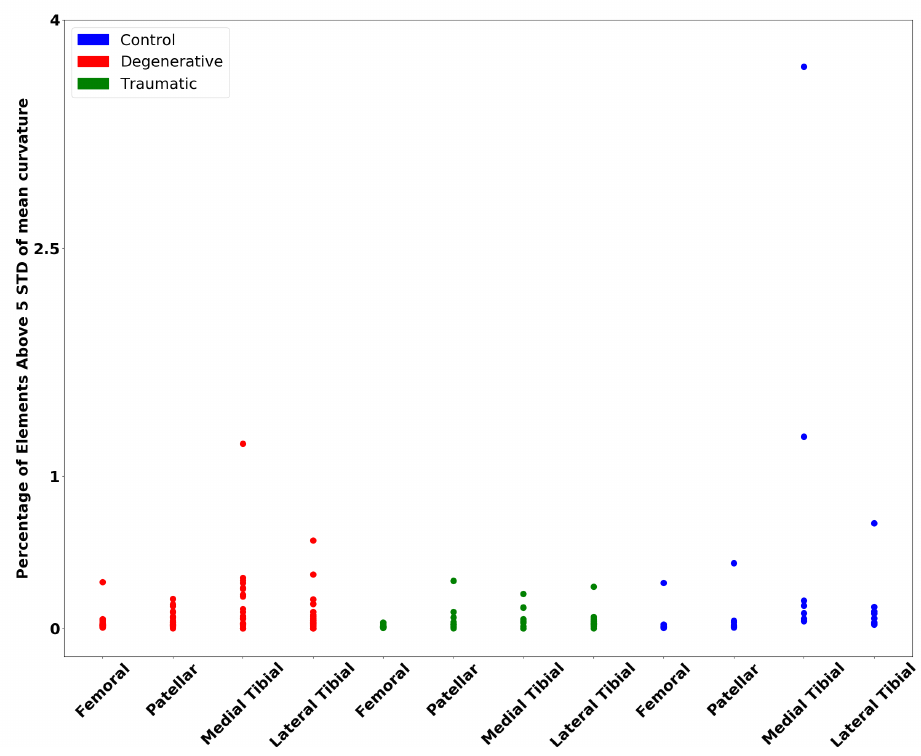
Figure 8. Percentage of elements above a certain standard deviation of the mean, using an STD weight of 5 for all cartilages as per Equation